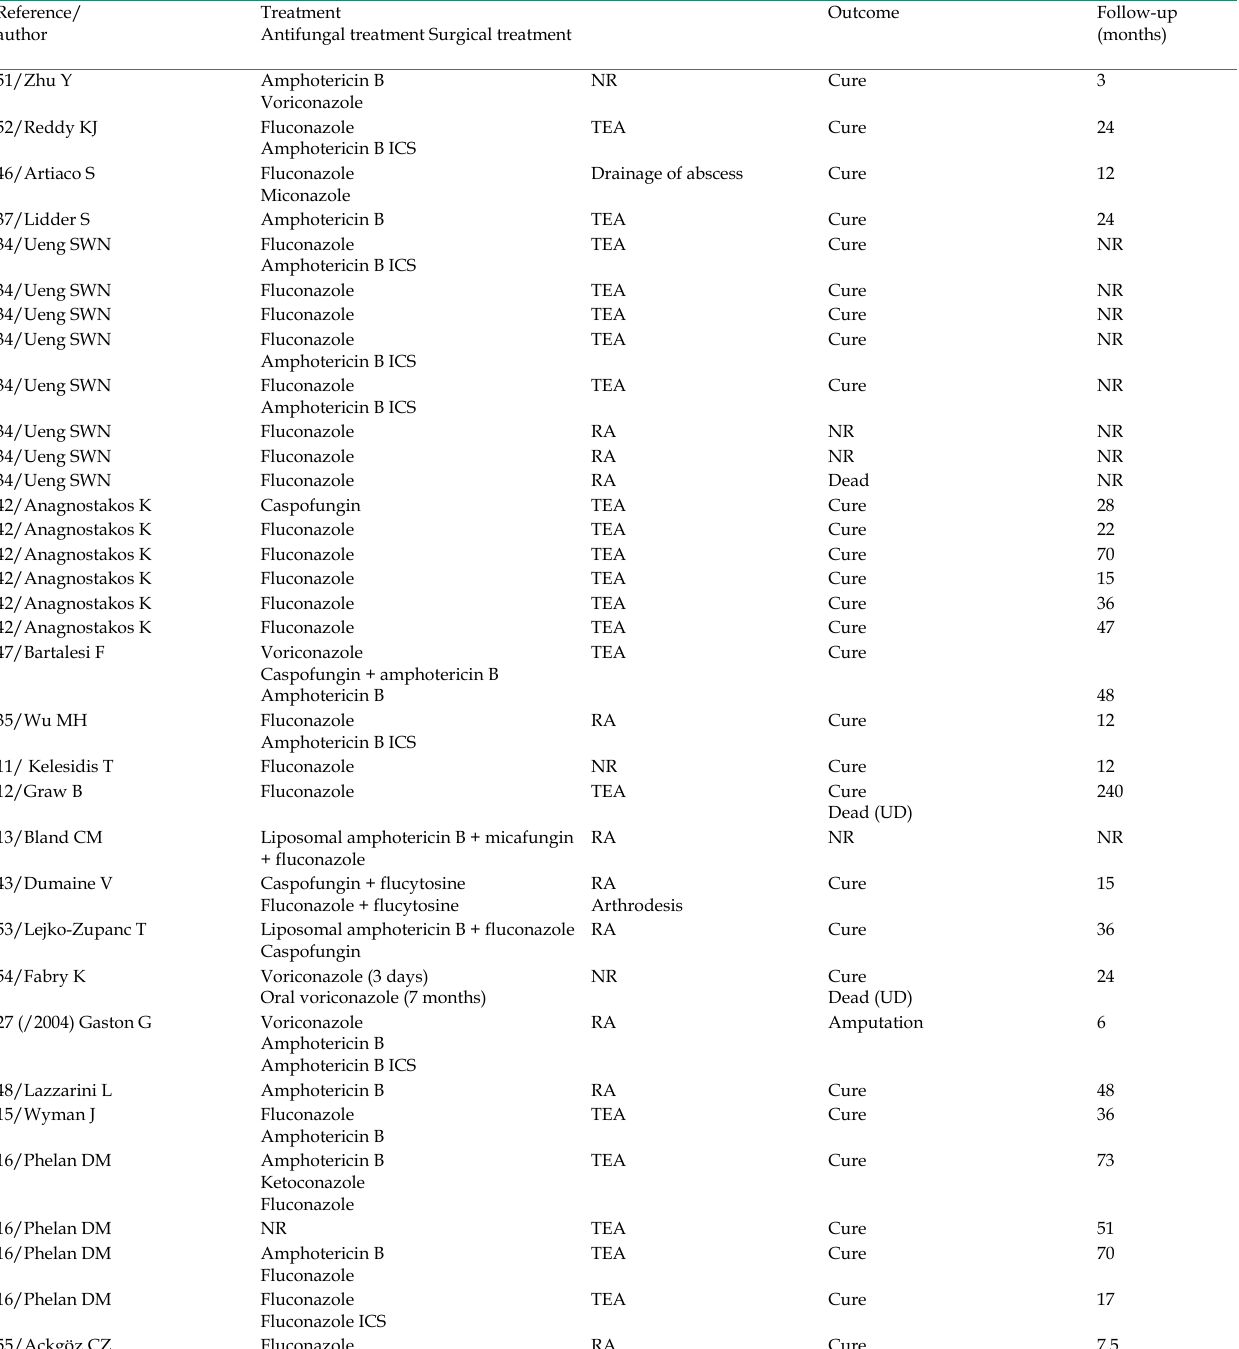
Table 1. Treatment, outcome and follow-up of 76 patients with Candida species